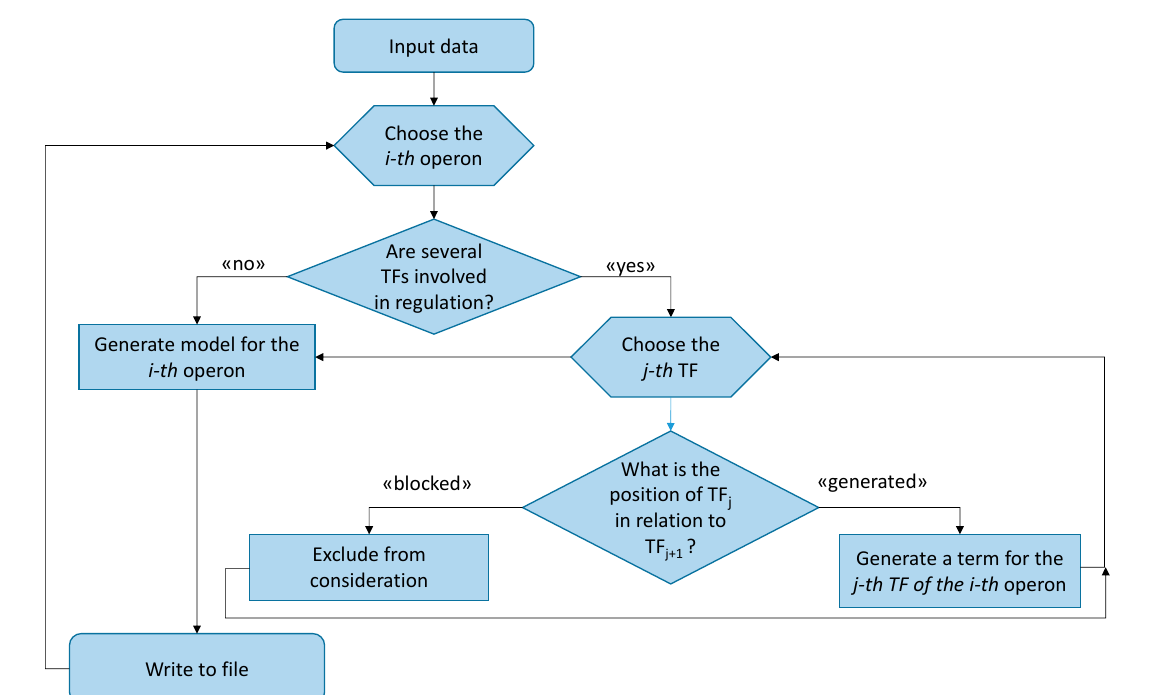
Figure 4. The execution scheme of the algorithm to generate regulation transcription models for an operon, where ‘generated’ means TFs which can bind TFBSs simultaneously (cases I and II in Figure 2) and ‘blocked’ means that they are incapable of doing so (cases III–VI in Figure 2).